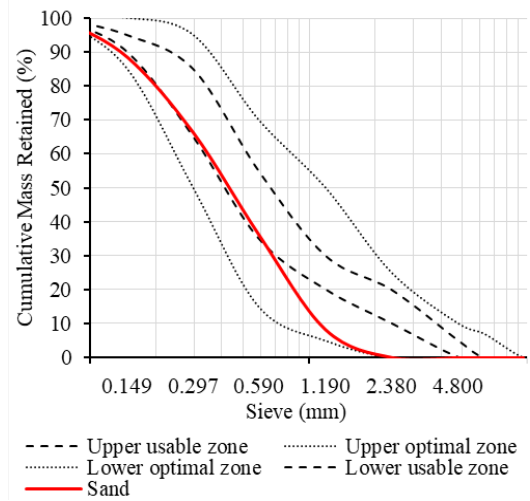
Figure 1. Fine aggregate particle size distribution.